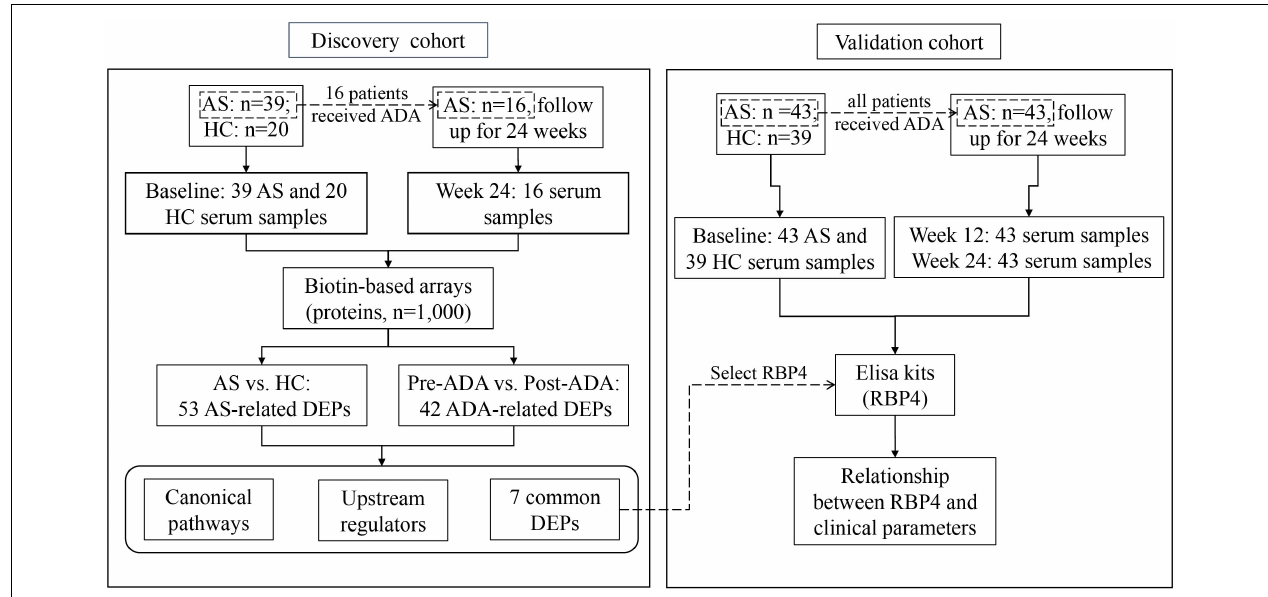
FIGURE 1 | Flow chart of the study. AS, ankylosing spondylitis; HC, healthy control; ADA, adalimumab; DEP, differentially expressed protein; RBP4, retinol-binding protein 4.